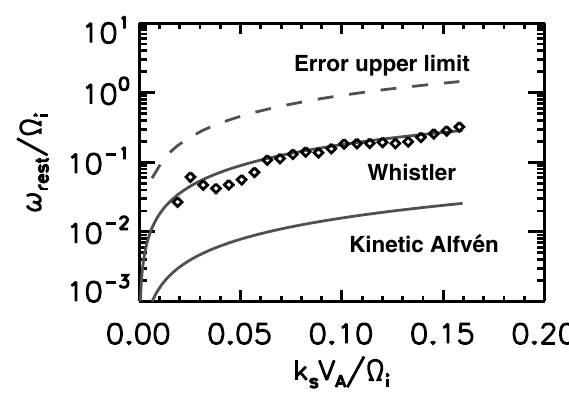
Figure 7. Estimated peak frequencies in the plasma rest frame (corrected for the Doppler shift) as a function of the streamwise wavenumbers (data points in black), upper limit of the frequency estimate error (dashed line in gray), and dispersion relations for the whistler mode (middle curve) and the kinetic Alfvén mode (lower